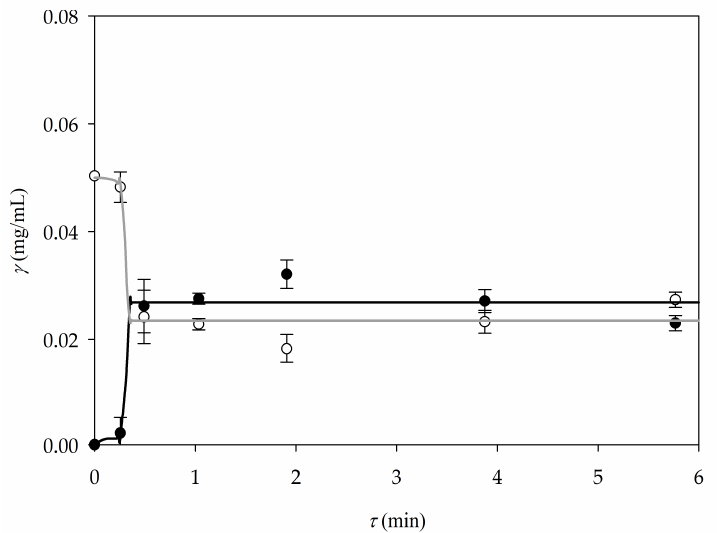
Figure 5. Effect of residence time on the mass concentration of xylanase in the raffinate and extract phases ( ● extract phase, ○ raffinate phase, ― mathematical model) .